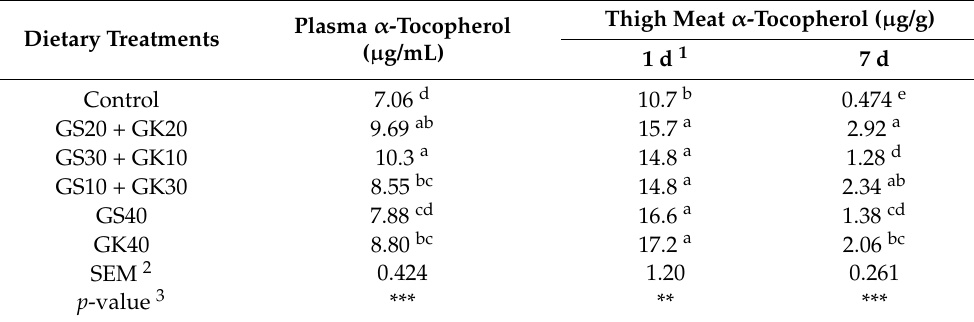
Table 4. Effect of grape seed (GS) and grape skin (GK) meals added at different dietary concentrations (g/kg) on plasma and thigh meat α -tocopherol concentration in broiler chickens. Dietary Treatments